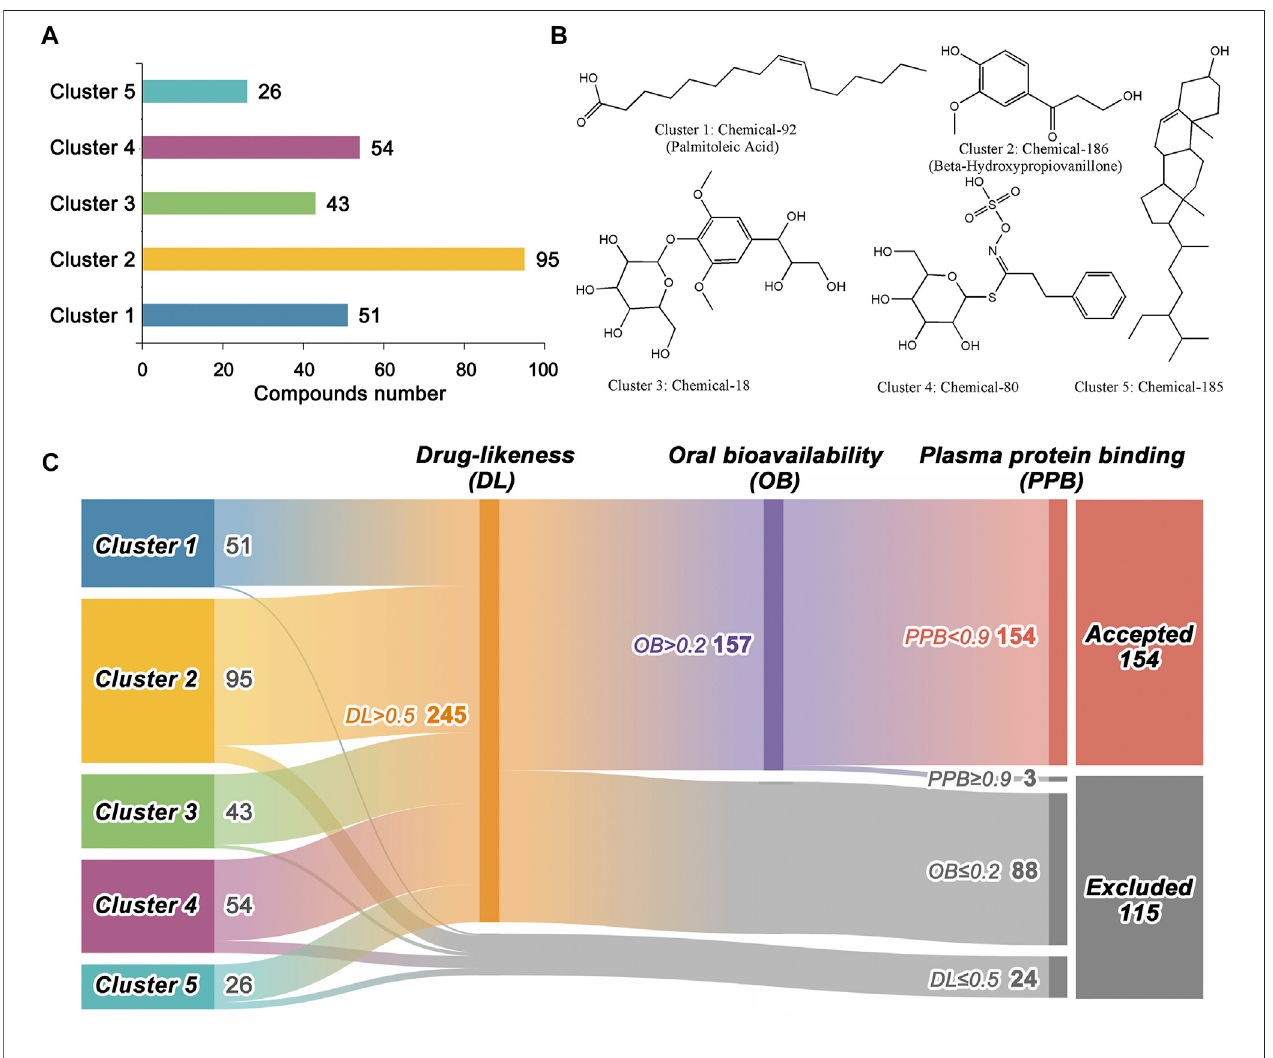
FIGURE2| Chemicalscaffoldclusteringanalysisandpreliminaryscreeningofthe269ingredientsin Isatistinctoria L.(BLG). (A) Statisticsofthestructuresinthe fi ve cluster groups. Compounds with similar Tanimoto distance were clustered together. (B) Representative structures of the fi ve cluster centers. (C) Drug-likeness and ADME(absorption,distribution,metabolism,andexcretion)screeningbasedonmachinelearningmodels.Detailedinformationisprovidedin SupplementaryTableS1 .